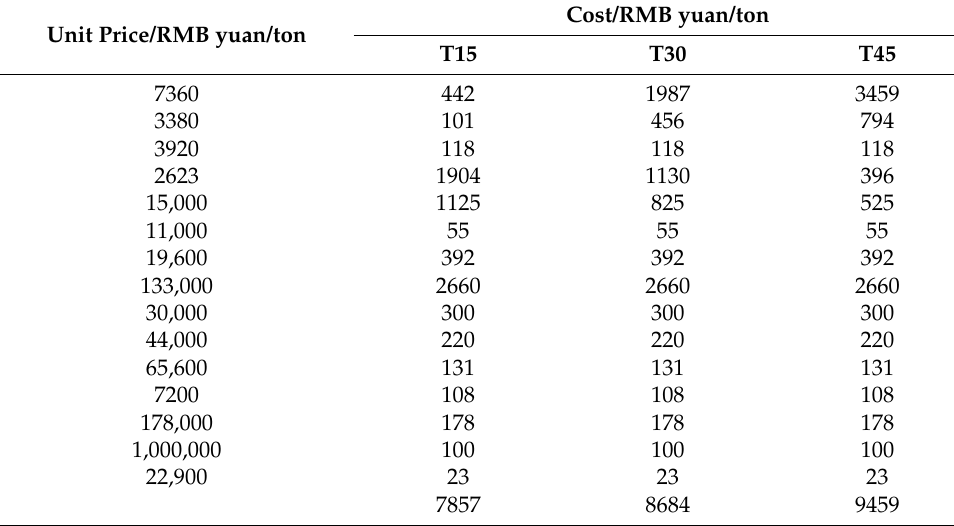
Table A1. The cost of each experimental feed.